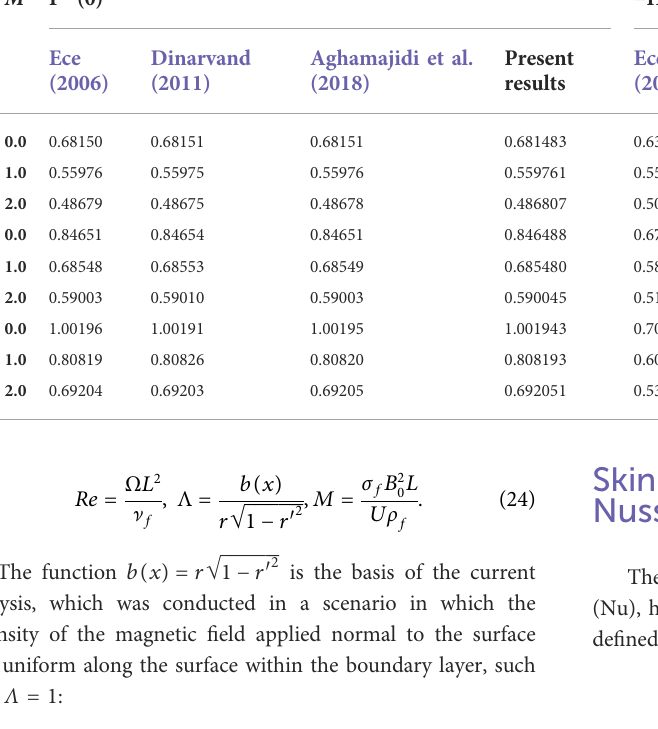
TABLE 2 Comparison with the results of Ece(2006),Dinarvand(2011),and Aghamajidi et al.(2018) for regular fl uid ( ϕ = 0), for the effect of Mand ∈ on F II (0) and – H l (0) with prescribed surface temperature, for Prandtl number =1.  M F ll